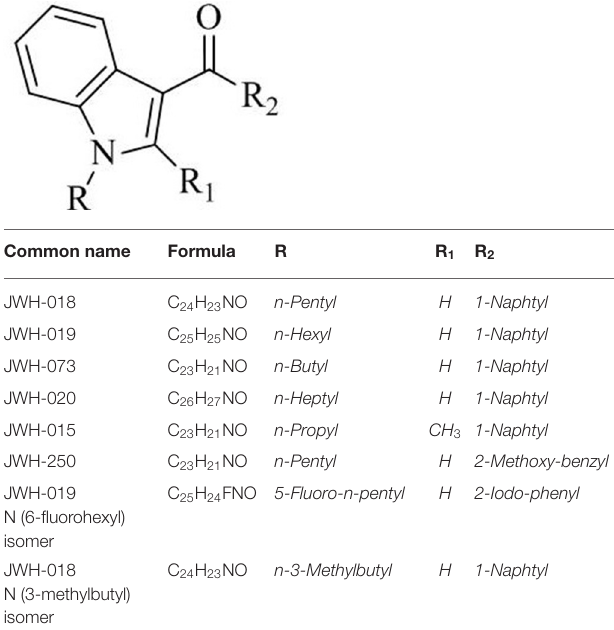
TABLE 1 | Akyl-3-acyl-indole derivatives of the JWH